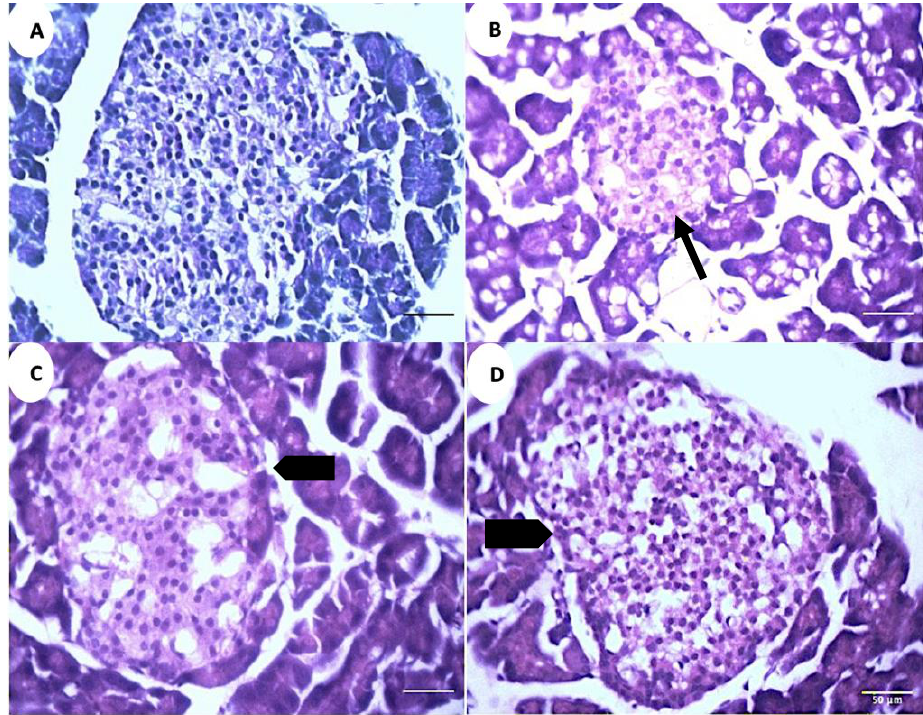
Figure 8. Representative photomicrographs of the islets of Langerhans in different treatment groups. ( A ). Negative control group (NC). ( B ). Positive control group (PC). ( C ). Treatment group 1 (GS1). ( D ). Treatment group 2 (GS2). Note the reduced diameter of the islet in the PC group (thin arrow) and the increase in the islet diameter in the GS2 treatment group (block arrow).